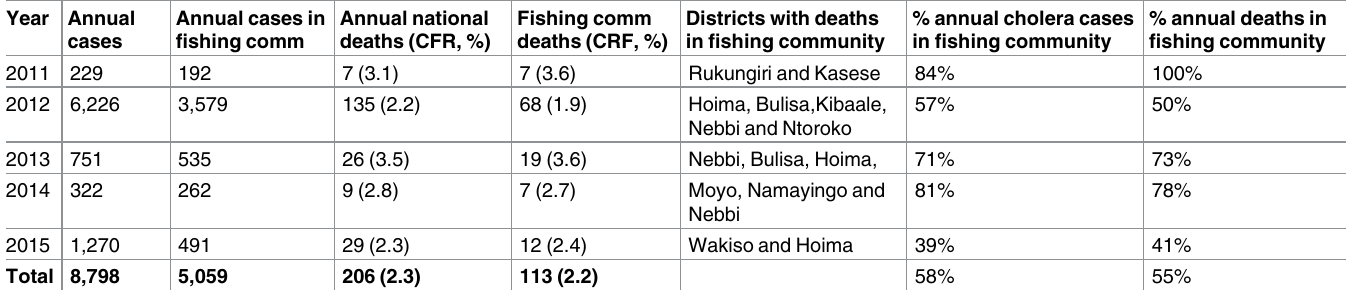
Table 2. Annual reported cholera cases and deaths in Uganda by district and by affected community,